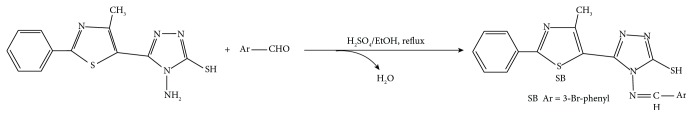
Synthesis of the Schiff base (SB).